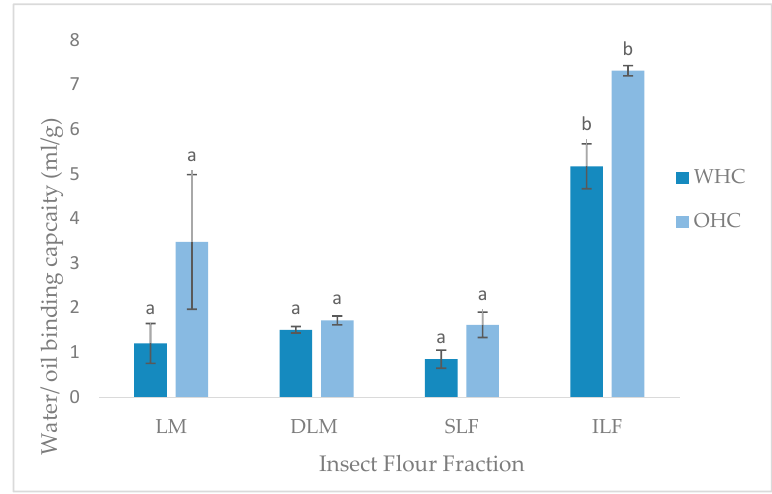
Figure 2. Water and oil holding capacities (ml/g) of locust meal (LM), defatted locust meal (DLM), soluble locust fraction (SLF), and insoluble locust fraction (ILF). Letters represents significant ( p < 0.05) differences. Error bars represent SD ( n = 2).